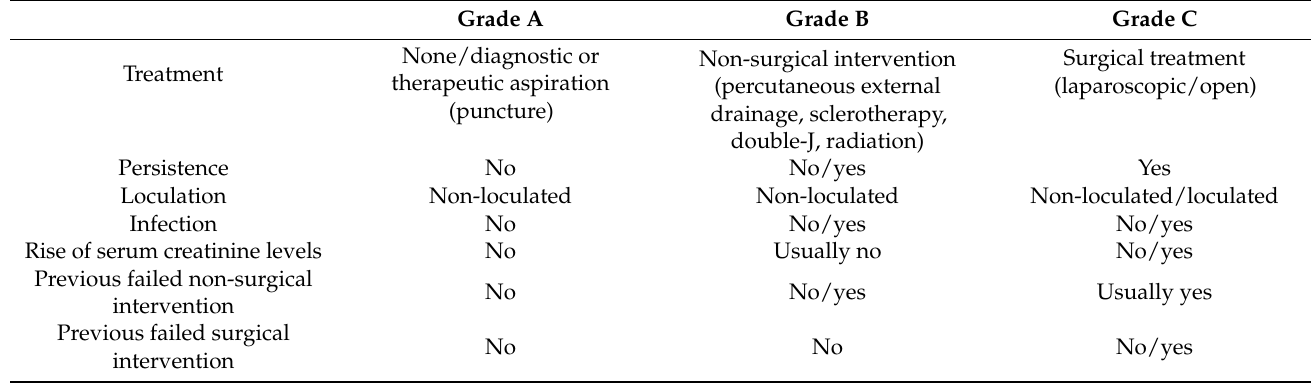
Severity grading of lymphatic complications after kidney transplantation based on the consensus from Mehrabi et al.